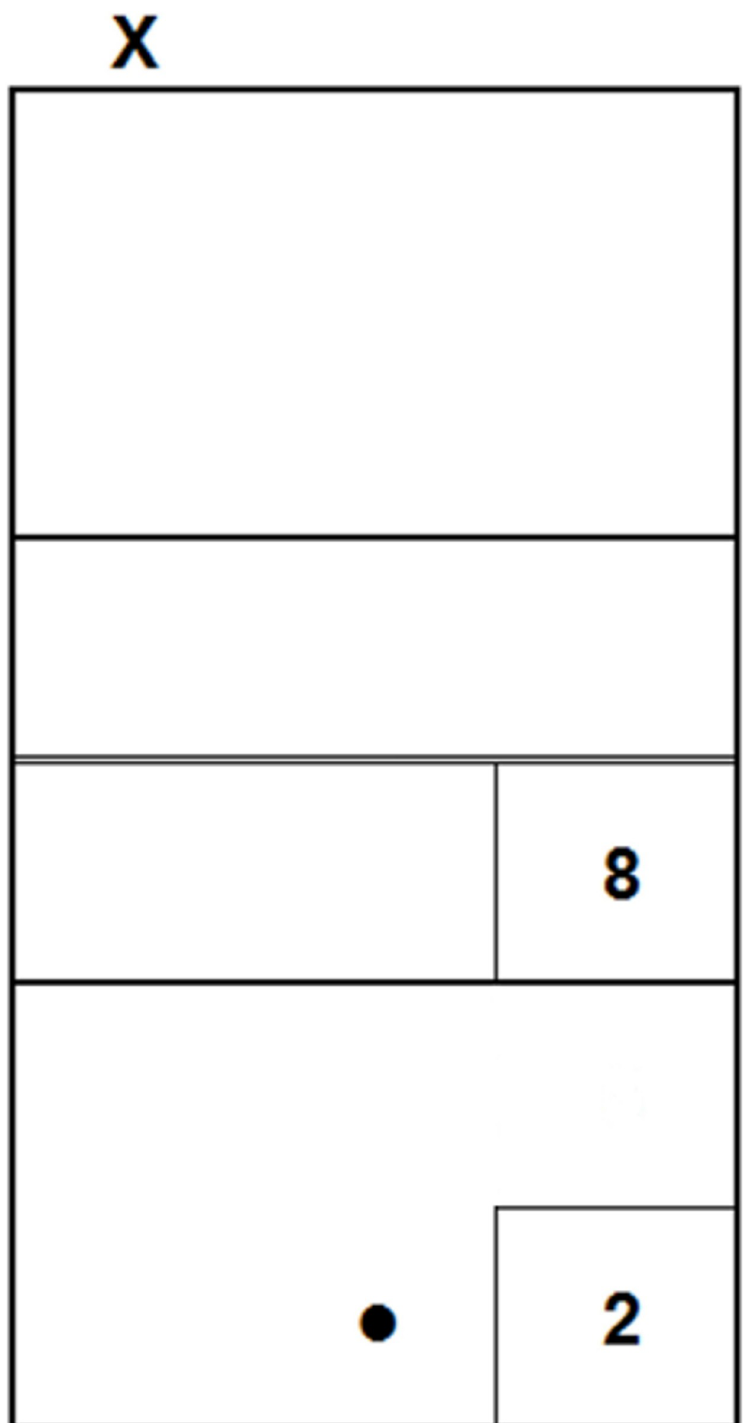
Fig 3. Correspondence between the sectors and the response keys on the keypad. This image was included in the instructions.